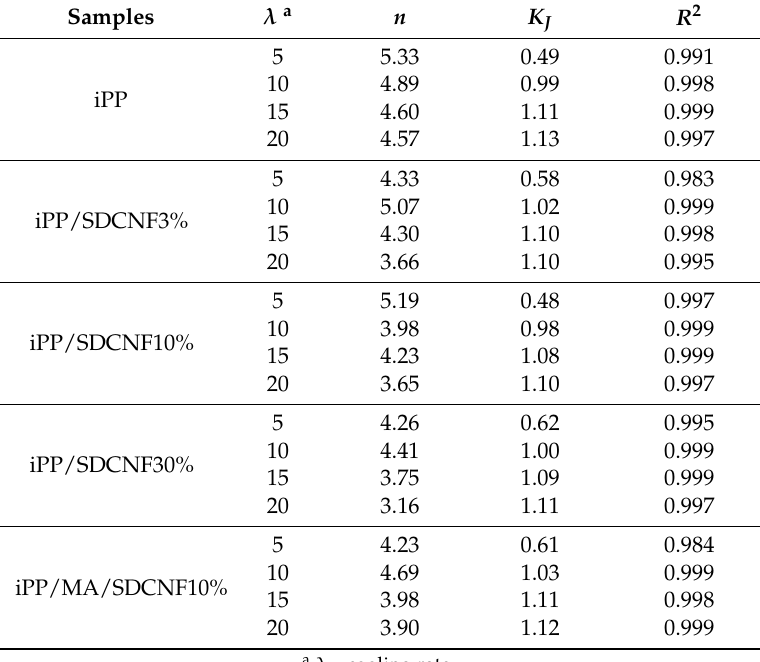
Table 4. Crystallization parameters calculated from Jeziorny